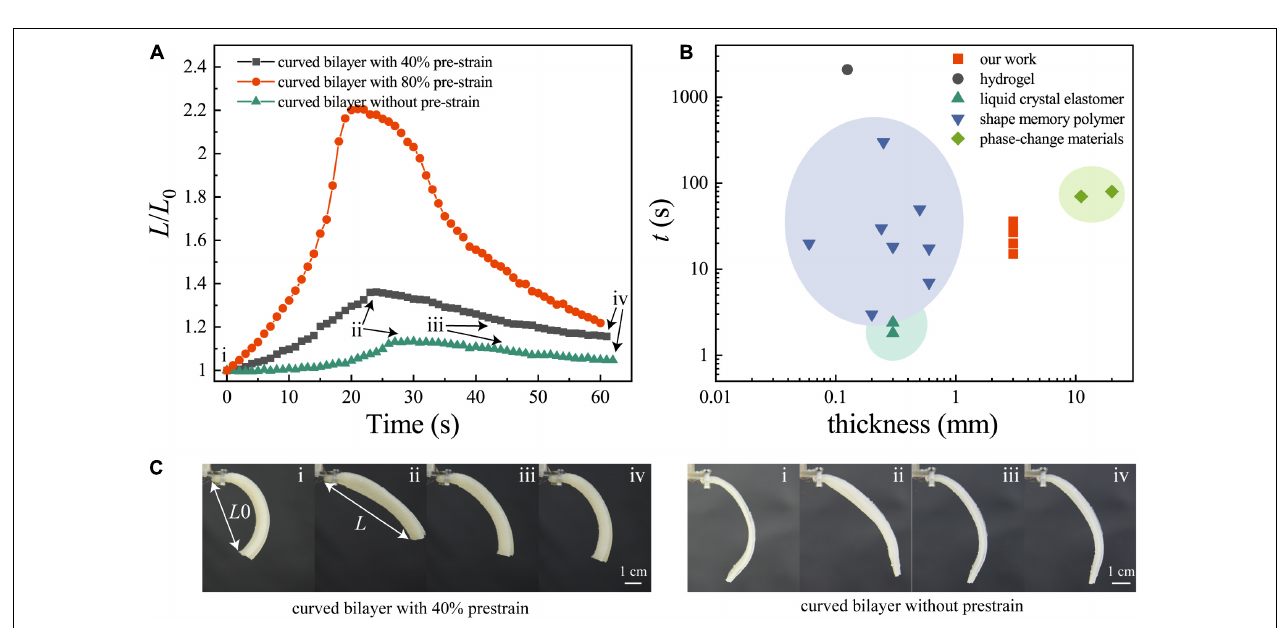
FIGURE 5 | FEA simulation results of wide pre-strain bilayer structure. (A) Variation in the curvature of pre-strained bilayer structure, (A) κ 1 and (B) κ 2 , as a function of temperature for different aspect ratios and pre-strains. (C,D) The shapes of pre-strained bilayer structure with different aspect ratio at 20 ◦ C (C) and 100 ◦ C (D) .